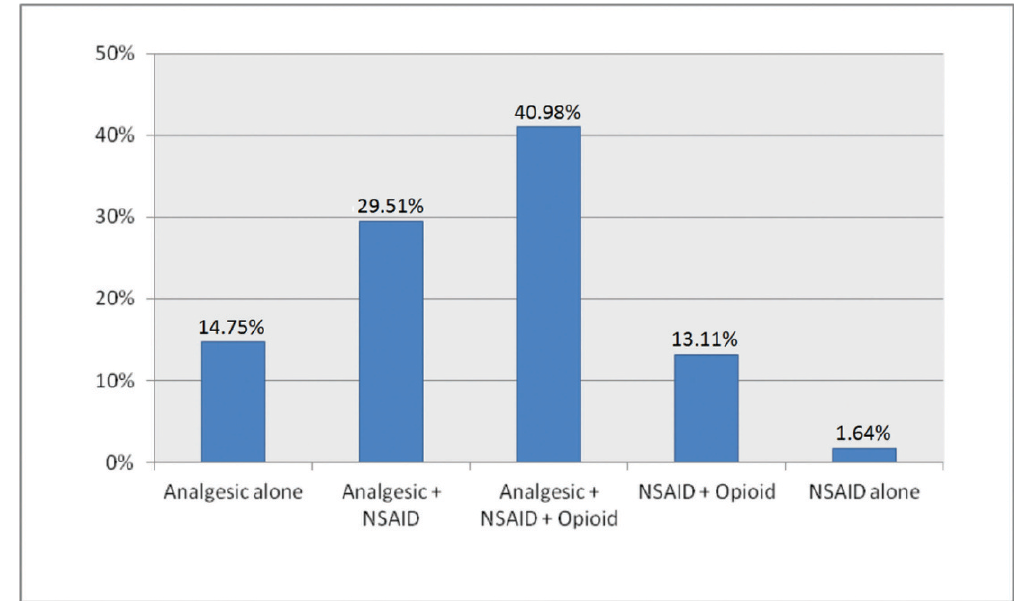
Figure 2 - The distribution of the prescribed drug combinations (the data are expressed as percentages).